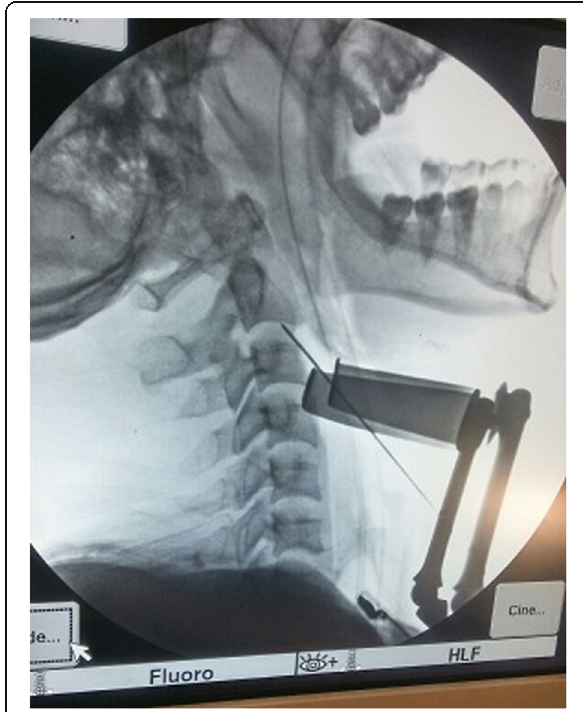
Fig. 2 Intraoperative image: the entry point is marked, and trajectory is achieved using the k-wire on lateral